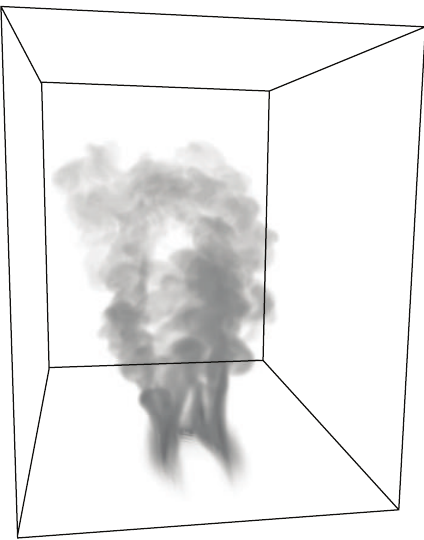
Figure 8: Bifurcated smoke plume from a computer simulation. View is from upwind of the fire (from Cunningham et al .